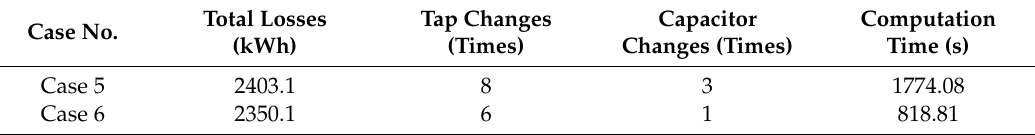
Table 4. Network losses, device adjustment times and time consumed by cases 5 and 6.